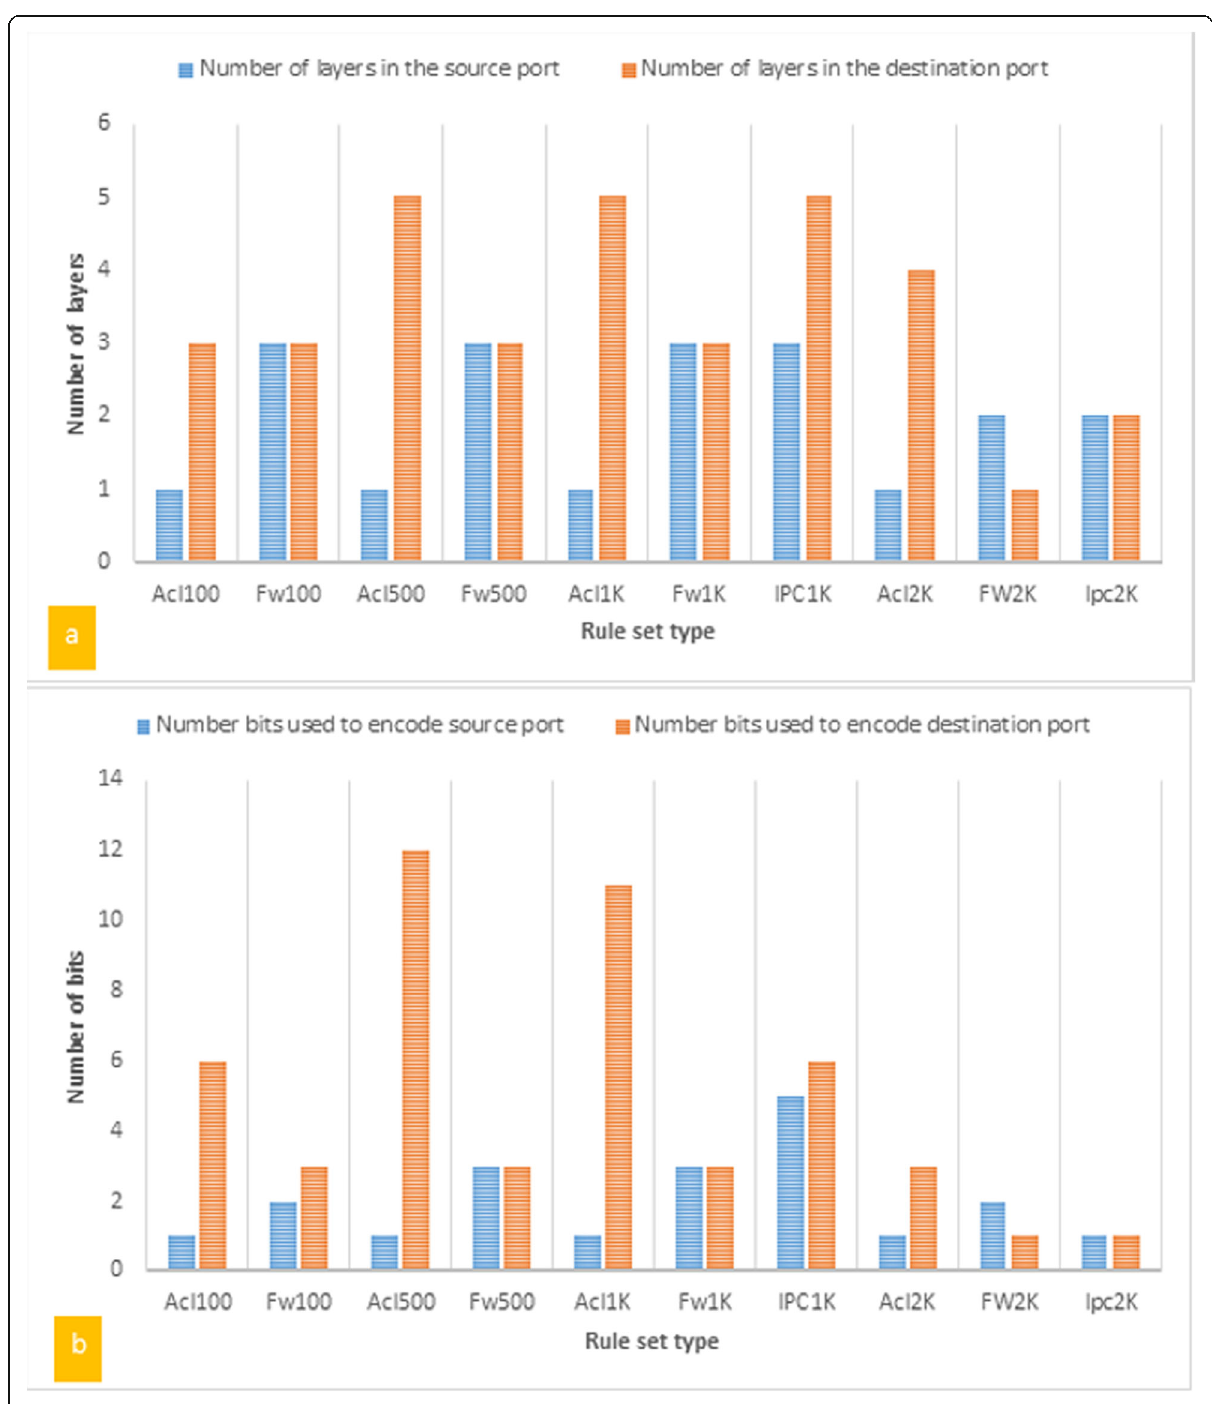
Fig. 7 a The number of layers for the source port and the destination port in ten different rule sets, b the number of bits used to encode the source port and the destination port in ten different rule